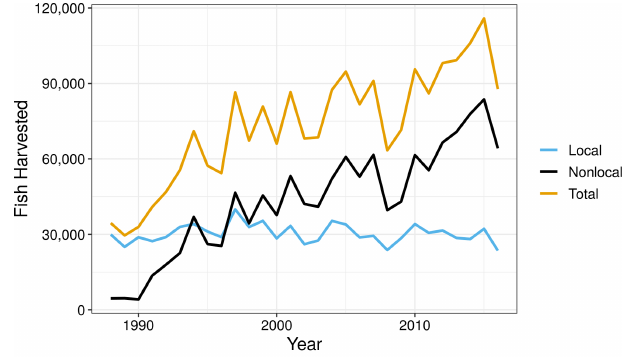
Fig. 4 . Local, nonlocal, and total salmon harvest for Glennallen subdistrict (in number of fish).